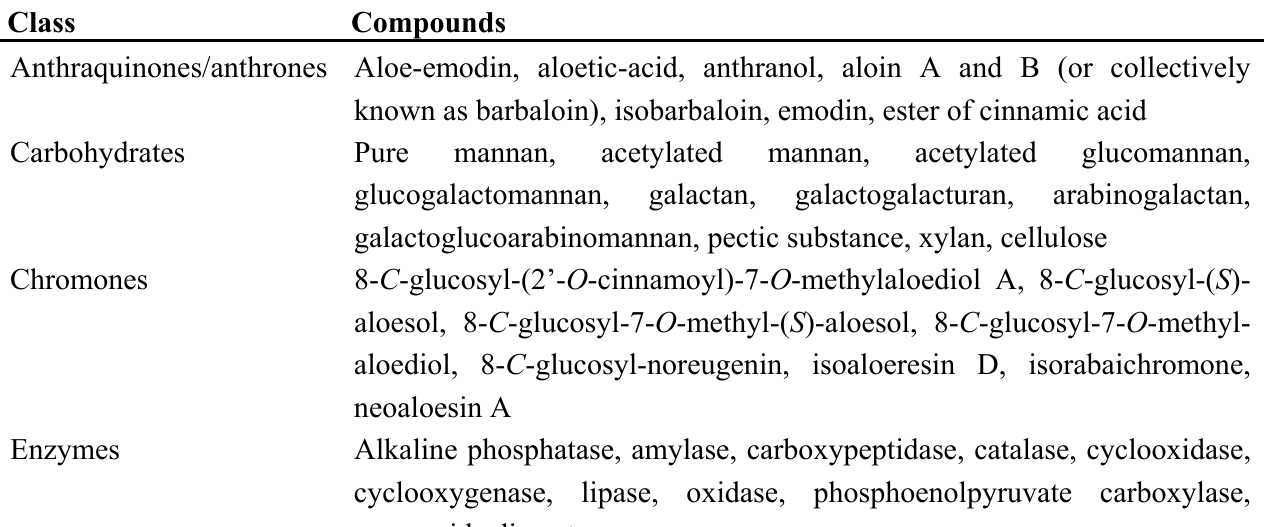
Table 1. Summary of the chemical composition of A. vera leaf pulp and exudate